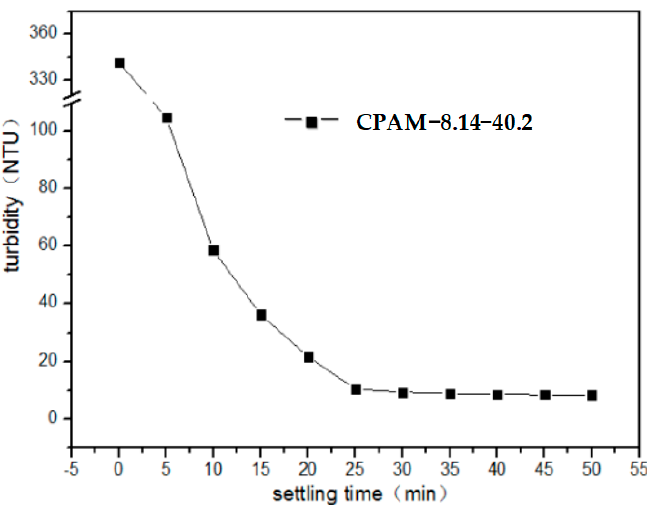
Figure 6. Impact of the settling time on the flocculation performance of